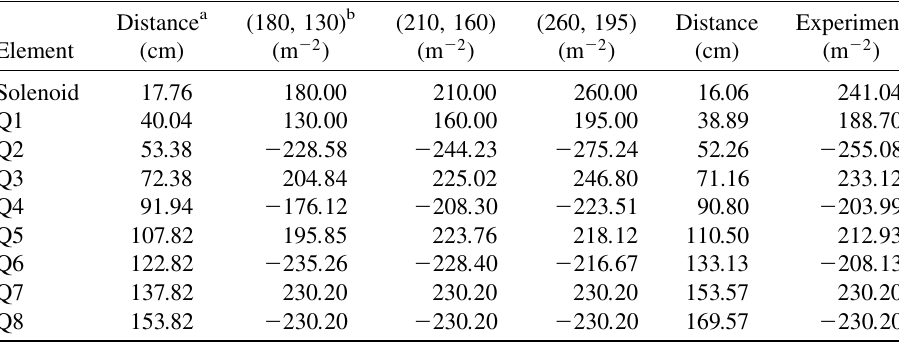
TABLE IV. Parameters for four source-to-FODO matching solutions in UMER with 100 mA, (cid:5) (cid:5) (cid:5) 72 : 92 (cid:12) . Columns 2–5 correspond to calculations for the 10 keV, (cid:4) (cid:5) 60 (cid:10) m , and (cid:5) 0 x 0 y matching/injection section shown in Fig. 1. The last two columns refer to an experiment with a prototype section [40]. See also Figs. 5, 7, and